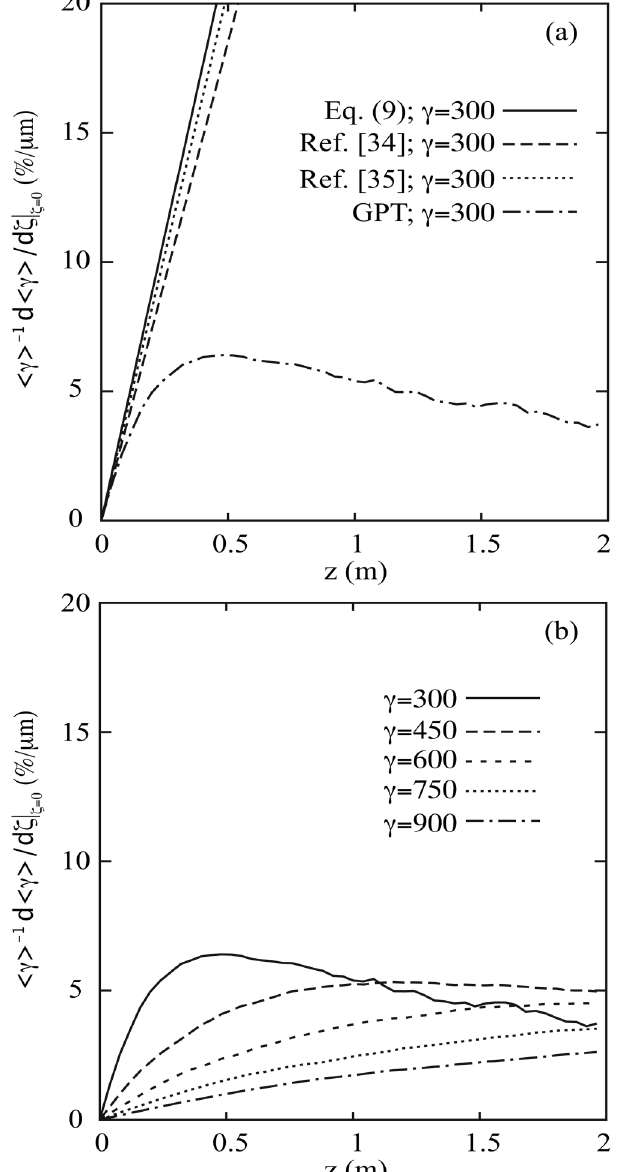
FIG. 6. Beam energy chirps h (cid:3) i (cid:1) 1 d h (cid:3) i =d(cid:4) (relative chirp per micron) at the beam centroid ( (cid:4) ¼ 0 ) versus z for different electron bunch energies calculated using GPT. The beam pa- rameters were (cid:5) z ¼ 1 (cid:2) m , (cid:5) x ¼ 30 (cid:2) m , and I ¼ 50 kA . (a) The chirp predicted by GPT (dash-dotted curve), the frozen beam approximation with (cid:3) ¼ 300 for a Gaussian bunch Eq. (9) (solid line), the results of Ref. [35] (dotted line), and Ref. [34] (dashed line). (b) Self-consistent GPT simulations of the space- charge induced chirp assuming (cid:3) ¼ 300 , 450, 600, 750, and 900 versus propagation